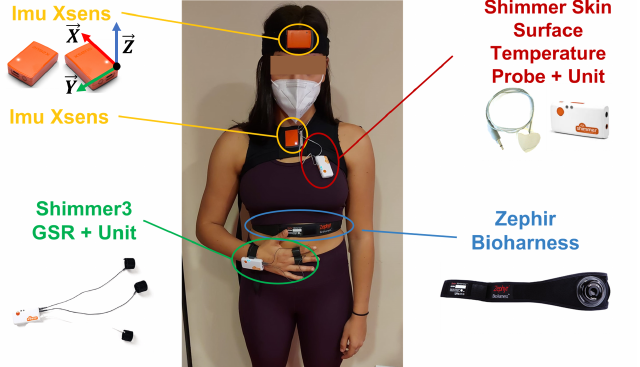
Figure 2. Experimental setup used during the experiments. The local reference frame of the M-IMU sensors is also